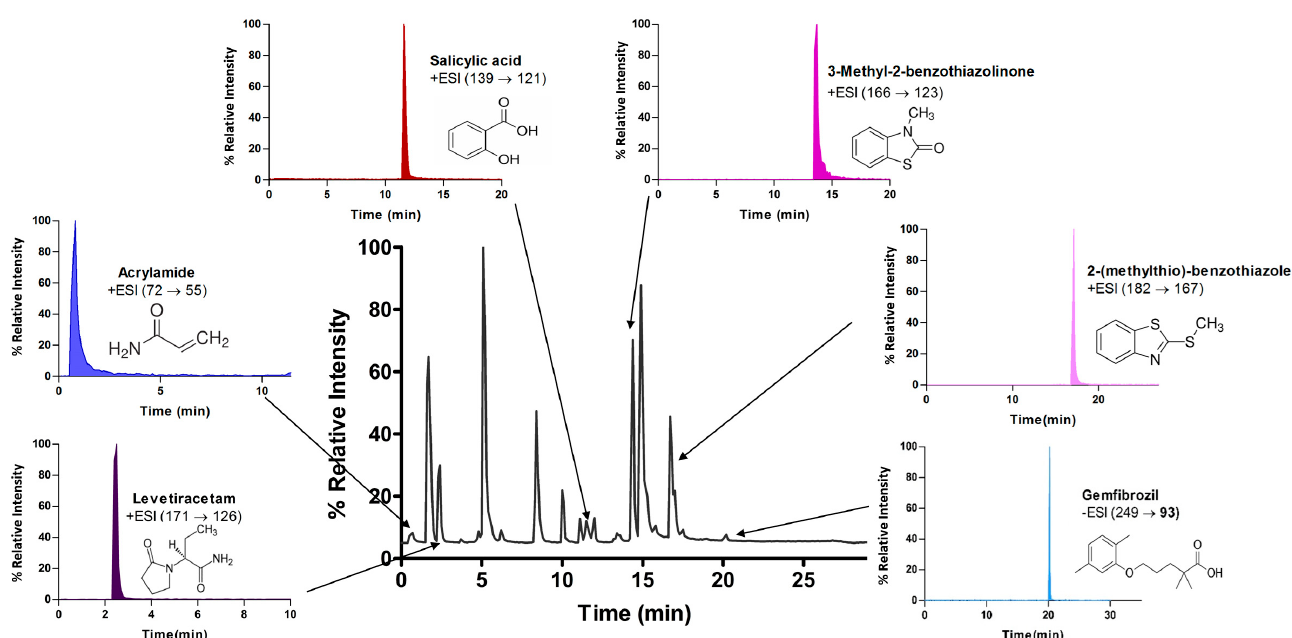
Figure 3. Typical combined LCMSMS MRM chromatogram of the mixture of 31 emerging pollutants at 4 ppm of each of them. The representative extracted MRM chromatograms of six chosen emerging pollutants (EPs) are also shown.